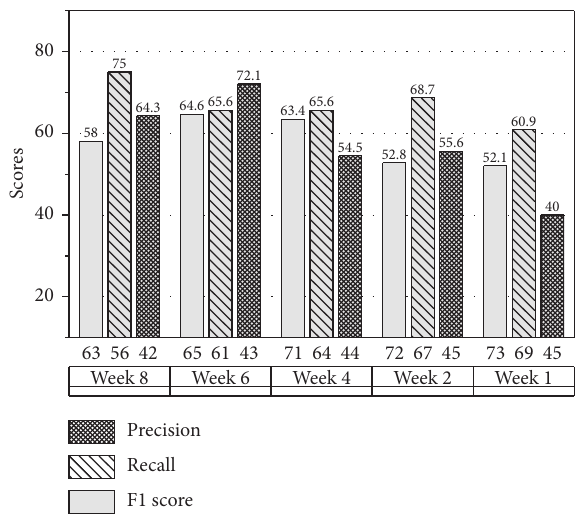
Figure 8: Recall and accuracy metrics